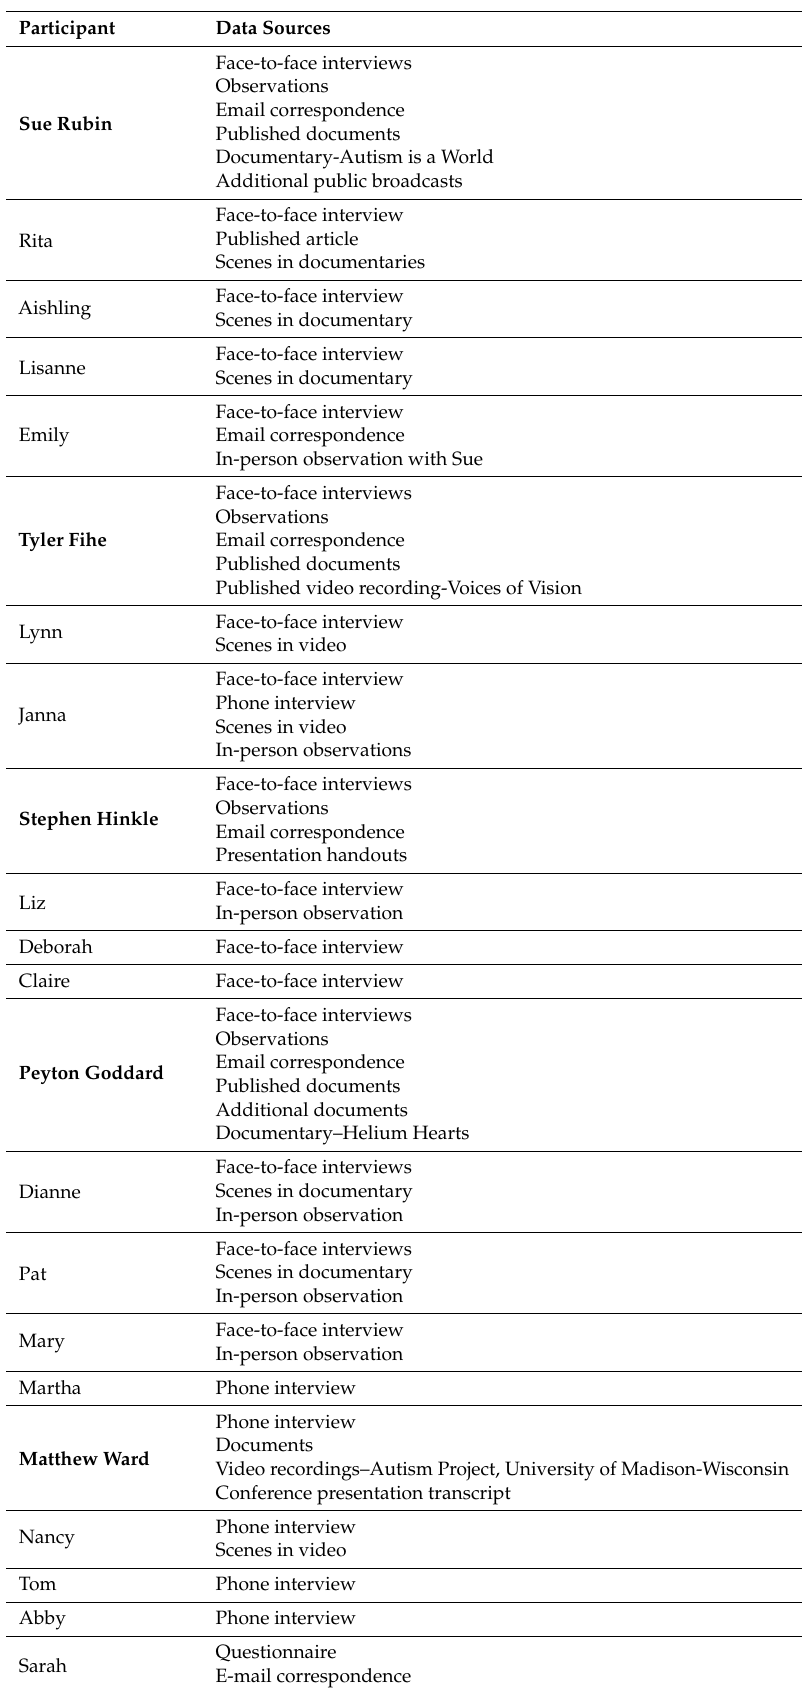
Table 2. Sources of